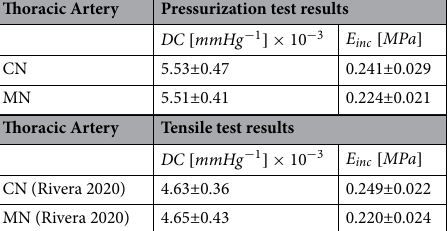
Table 2. Distensibility, DC , and incremental modulus of elasticity, E inc , obtained in the tensile by Rivera 2 and pressurization tests obtained in this work, with axial stretch (cid:31) z = 1.20 . Values were expressed as Mean ± SEM. Significant differences ( P ≤ 0.05 ): * vs. CN.